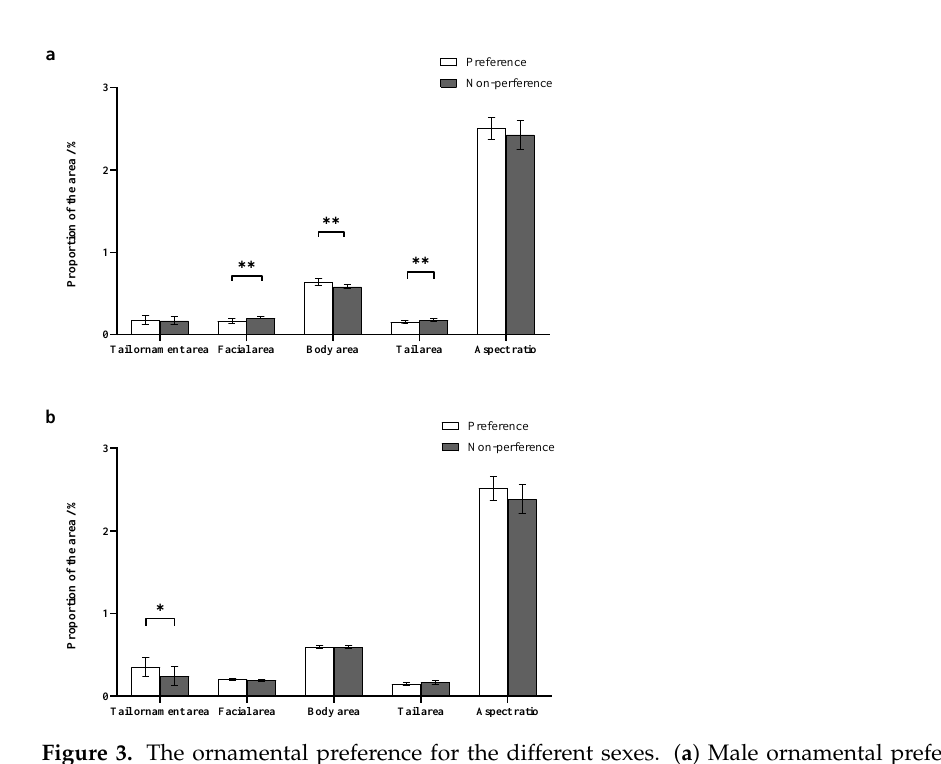
Figure 3. The ornamental preference for the different sexes. ( a ) Male ornamental preference in Experiment 1; ( b ) Female ornamental preference in Experiment 2. A significant difference is denoted by an asterisk.